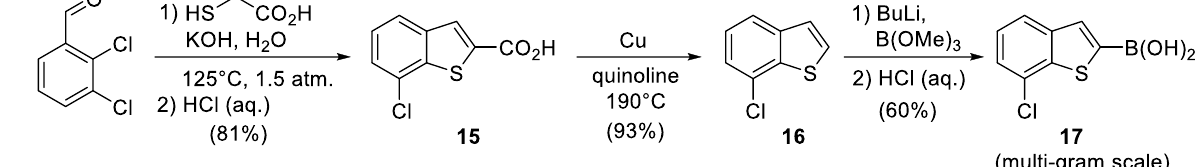
Figure 5. Synthesis of (7-chlorobenzo[ b ]thiophen-2-yl) boronic acid.